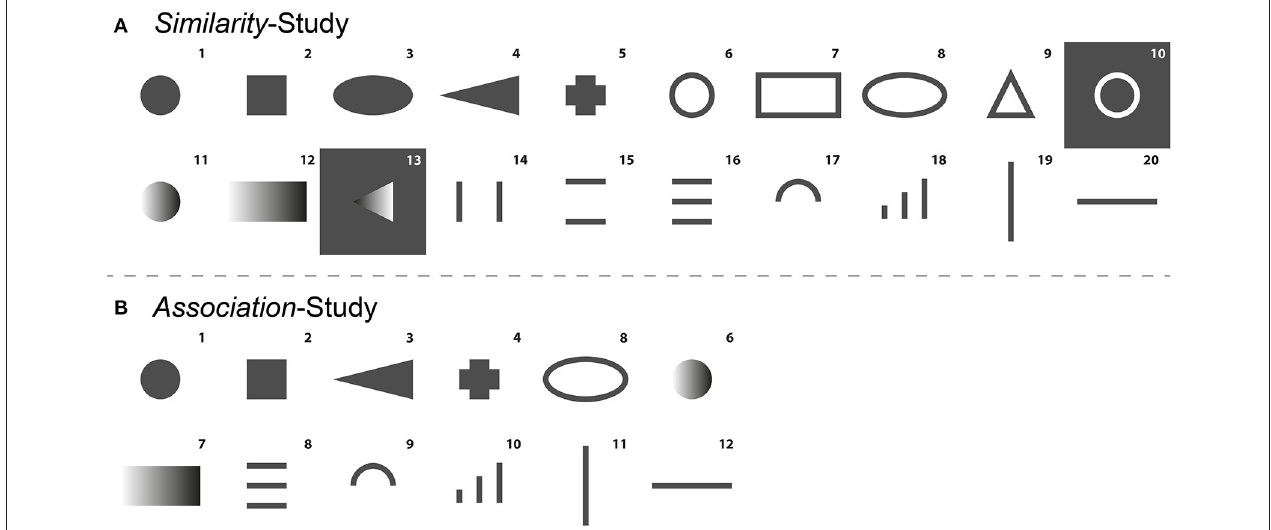
the general, underlying association pattern of forms and their perceived functionality. For data preparation, ratings of the pairwise comparisons were averaged across all the